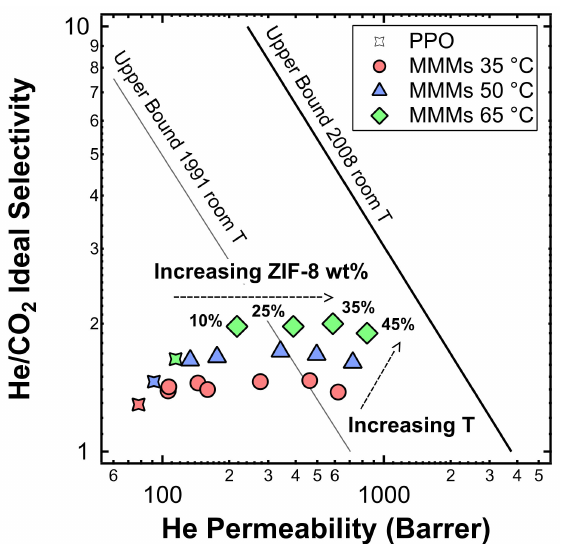
Figure 24. Positioning of the MMMs studied in this work in a Robeson plot for He / CO 2 separation. For data collected at 35 ◦ C, filler loadings of 0%, 3%, 6%, 10%, 15%, 25%, 35%, and 45% in weight of ZIF-8 were tested. For data collected at 50 ◦ C, filler loadings are equal to 0wt%, 3 wt%, 10 wt%, 25 wt%, 35 wt%, and 45 wt%, while for data collected at 65 ◦ C, only data at wt %, 10 wt%, 25 wt%, 35 wt%, and 45 wt% were collected. The e ff ect of the temperature is also